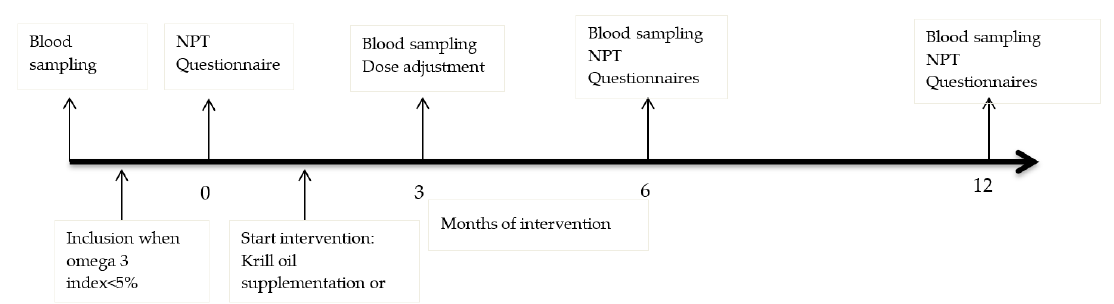
Figure 1. Timeline of study. NPT = neuropsychological tests, at all time points equal: Letter Digit Substitution Test, D2 test of attention, digit span forward and backward, Concept Shifting Test and Stroop test.